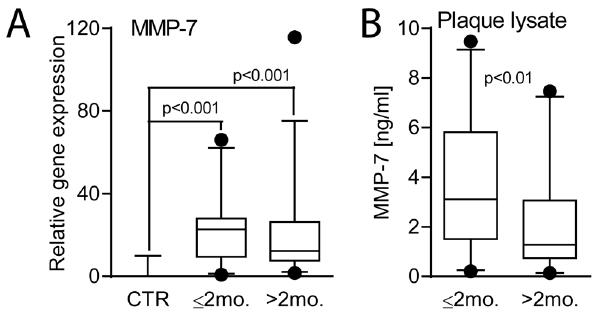
Figure 2. The expression of MMP-7 within atherosclerotic carotid plaques in relation to plaque symptomatology. mRNA ( A ) and protein ( B ) levels of MMP-7 in atherosclerotic carotid plaques were measured in (i) patients with the most recent symptoms (within the last 2 months, n=35) and (ii) patients with symptoms . 2 months ago and asymptomatic patients ( . 2 months, n=29). For comparison, mRNA levels of MMP-7 were also analyzed in non-atherosclerotic vessels (common iliac artery) from 10 organ donors (CTR). mRNA levels were quantified by real-time RT-PCR. The expression of b -actin was used as endogenous control. Protein levels of MMP-7 were measured in plaque lysates by EIA. Data are shown as a box and whisker plot with median (Q1, Q3) in the box and the whiskers representing the 5 and 95 percentile in relation to b -actin expression.